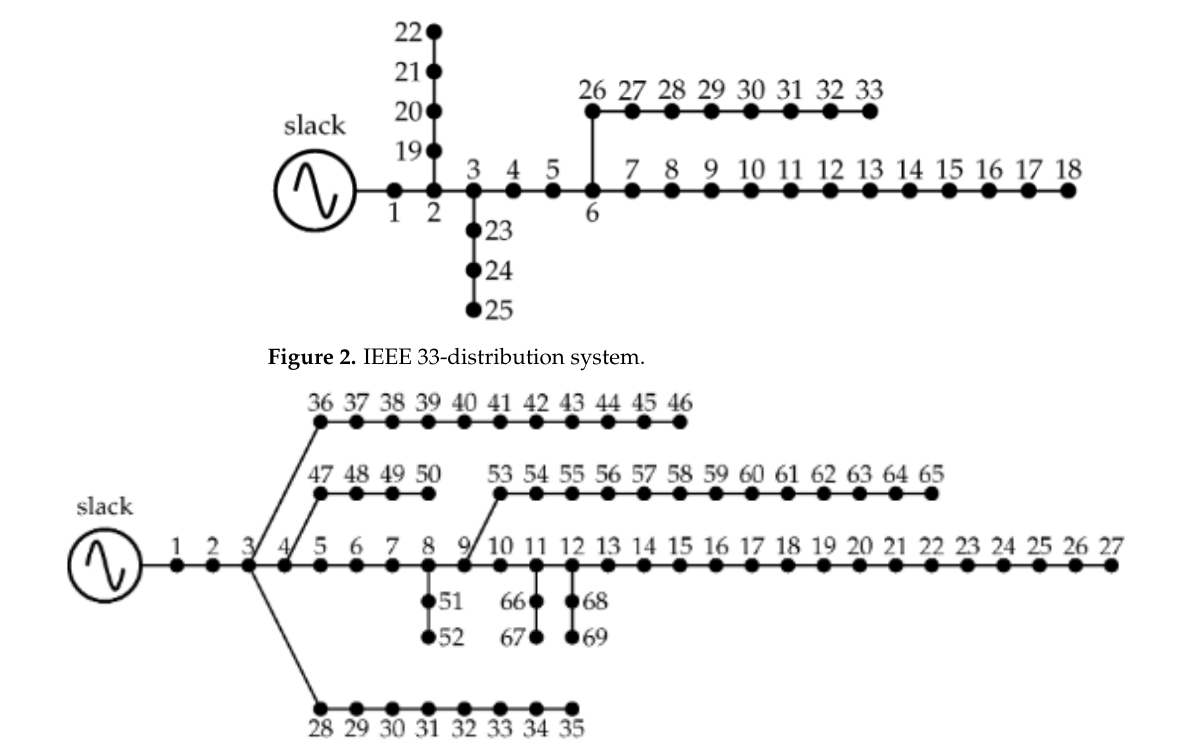
Figure 3. IEEE 69-distribution system.